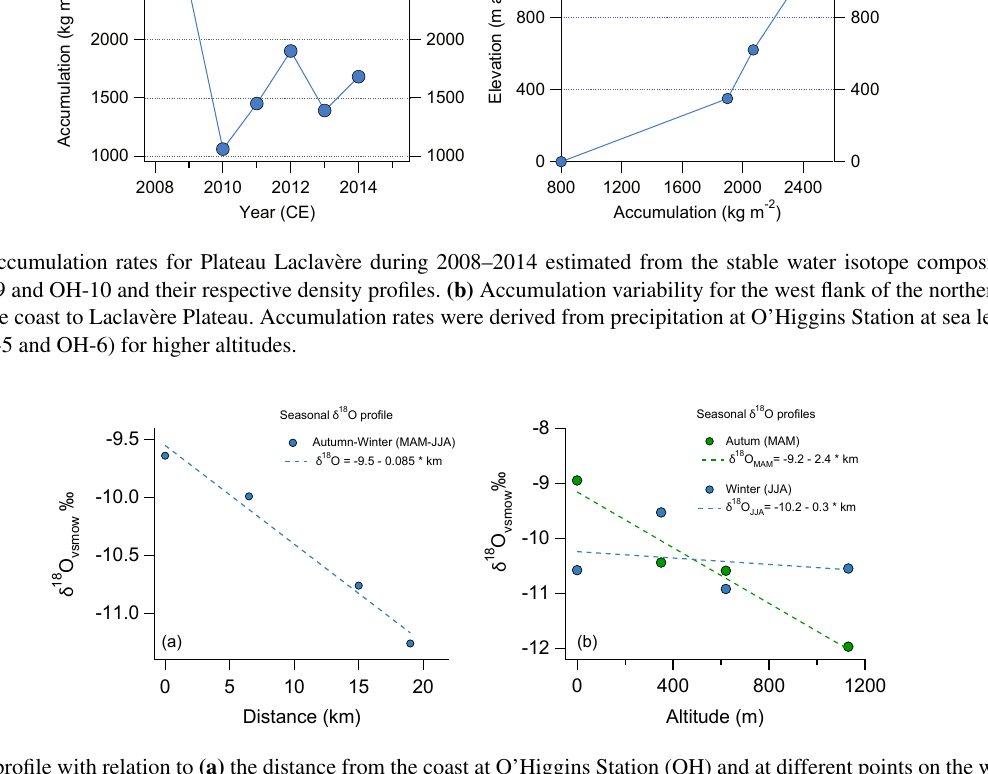
Figure 14. δ 18 O profile with relation to (a) the distance from the coast at O’Higgins Station (OH) and at different points on the west flank of the AP (6.5km (OH-4), 15km (OH-5) and 19km (OH-6)) and (b) altitude at 350m (OH-4), 620m (OH-5) and 1130ma . s . l . (OH-6) during autumn (MAM) (green solid dots) and winter (JJA) (blue solid